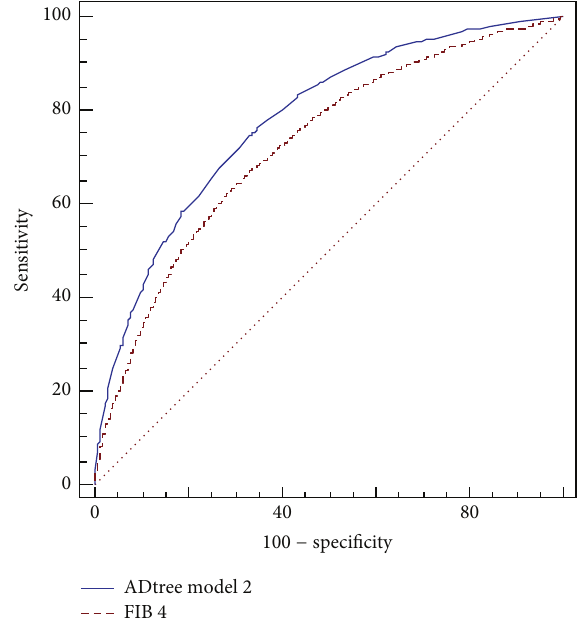
Figure 3: Comparison between the ROC curves of proposed ADTreeModel2andFIB4.ItshowsanimprovedAUROCformodel